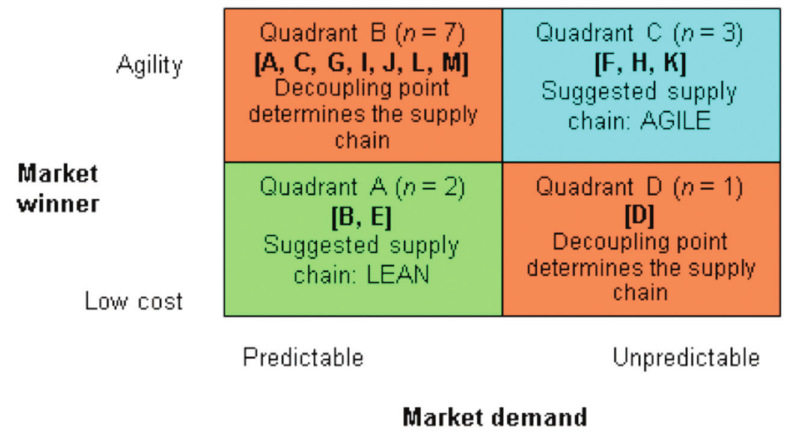
Figure 2: Market demand predictability and market winner